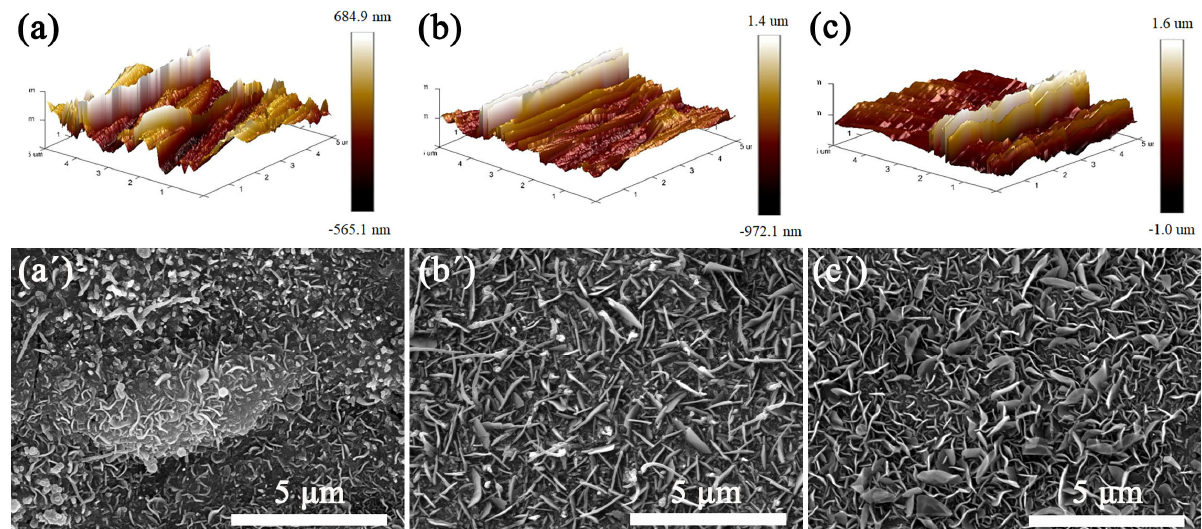
Figure 3. AFM images of SS with different Ra values of ( a ) 149 nm, ( b ) 199 nm, ( c ) 224 nm; ( a ′ – c ′ ) SEM images of VGNs/CF composite films obtained by spraying a 0.6 g/mL glucose and CF mixture onto the SS surface of the corresponding roughness.